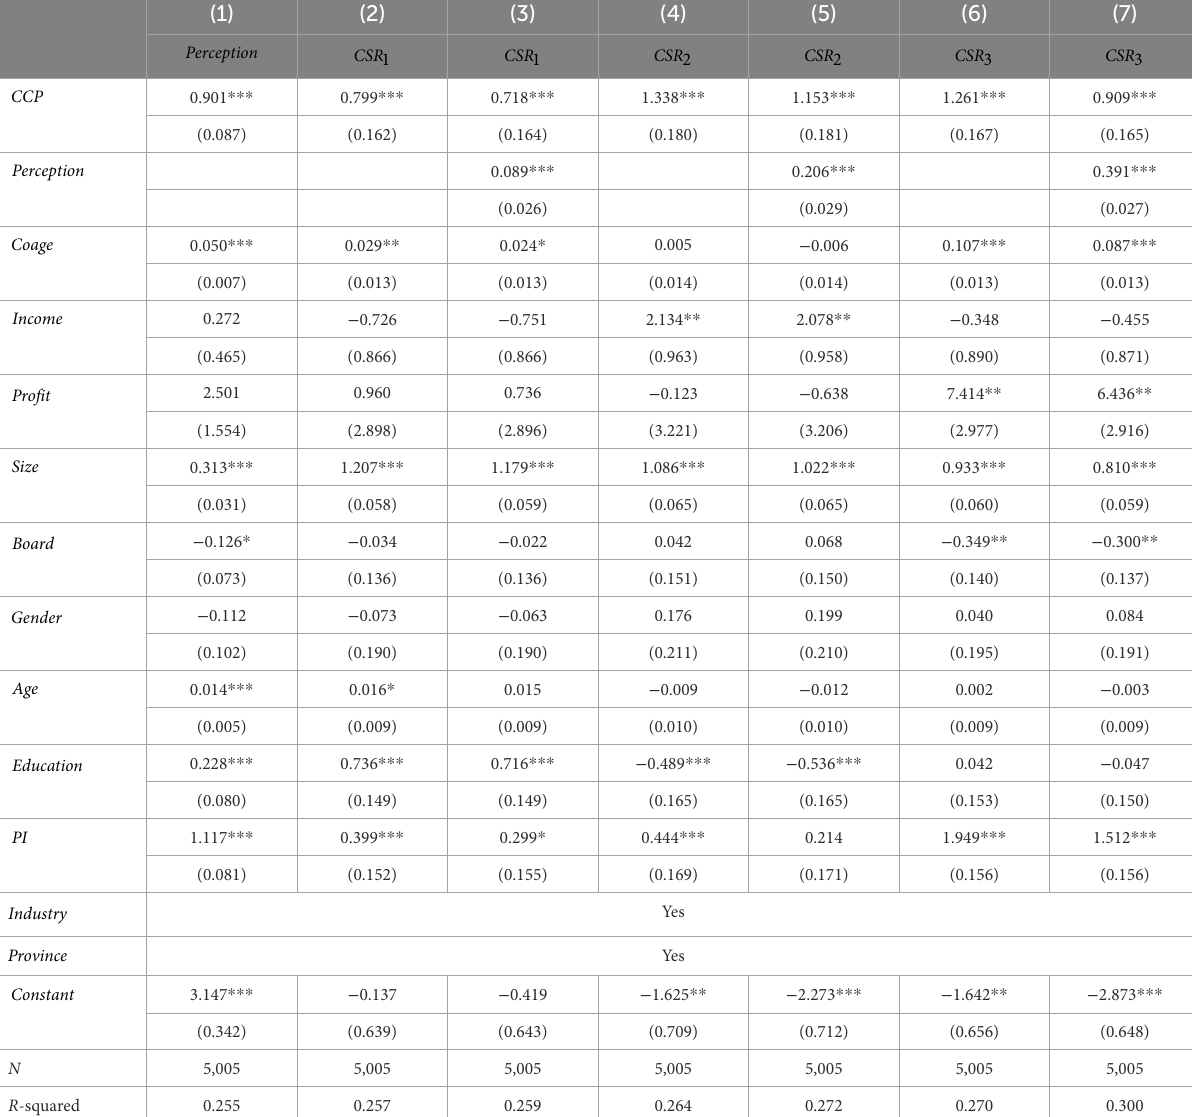
TABLE 4 Party branches and CSR in Chinese private enterprises: Mediating effects of policy